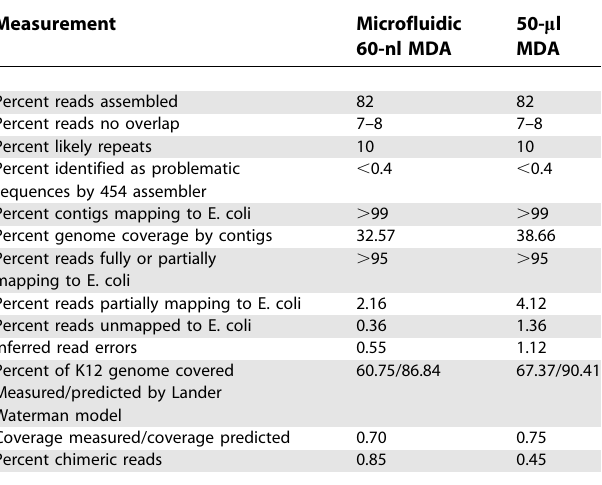
Table 1. Sequencing Statistics